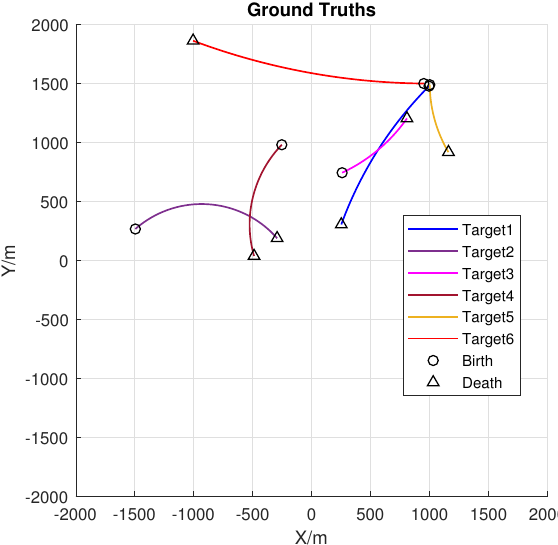
Figure 4. The ground truths of the simulations. (in total, six targets are involved with different colors to distinguish).